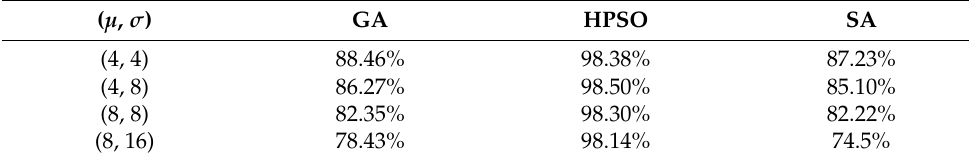
Table 14. The success rate of the algorithm under different µ and σ .